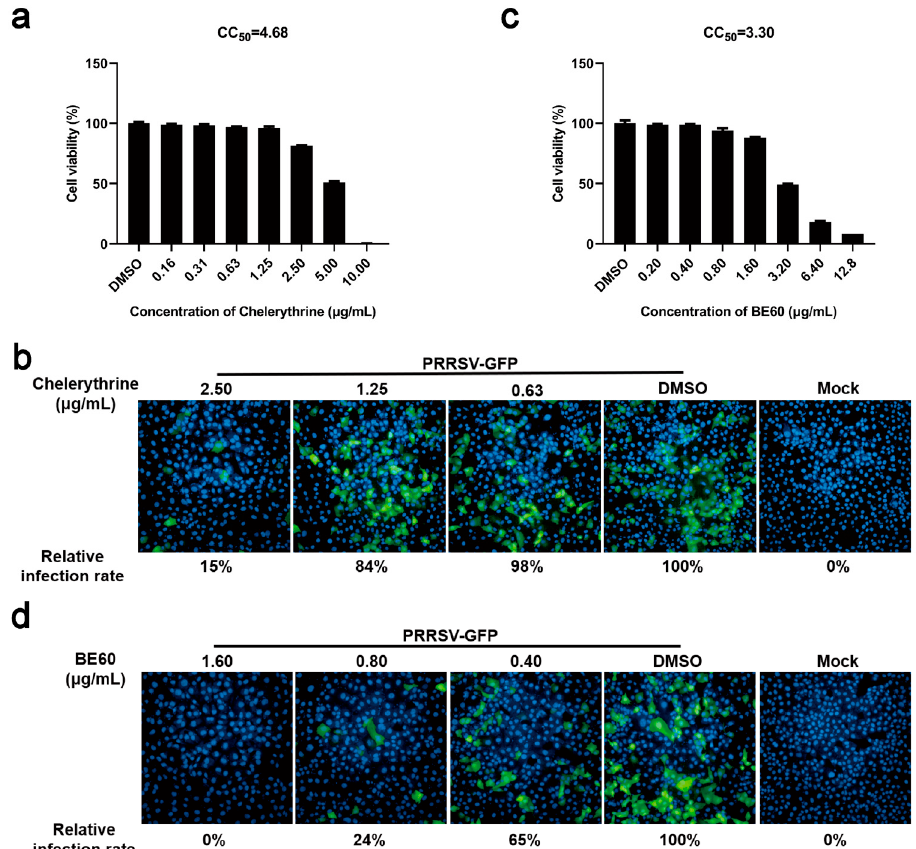
Figure 7. Combined use of sanguinarine and chelerythrine exerts potent antiviral efficacy against PRRSV. ( a , c ) MARC-145 cells were incubated with chelerythrine ( a ) at different concentrations (10.00, 5.00, 2.50, 1.25, 0.63, 0.31, and 0.16 µ g/mL) or BE60 ( c ) at various concentrations (25.60, 12.80, 6.40, 3.20, 1.60, 0.80, and 0.40 µ g/mL) for 36 h, respectively. Then, the cell viability was detected using CellTiter-Glo Luminescent Cell Viability Assay. Data are expressed as the means from three independent experiments. ( b , d ) MARC-145 cells were incubated with chelerythrine ( b ) (2.50, 1.25, and 0.63 µ g/mL) or BE60 ( d ) (1.60, 0.80, and 0.40 µ g/mL) and infected with PRRSV (MOI =